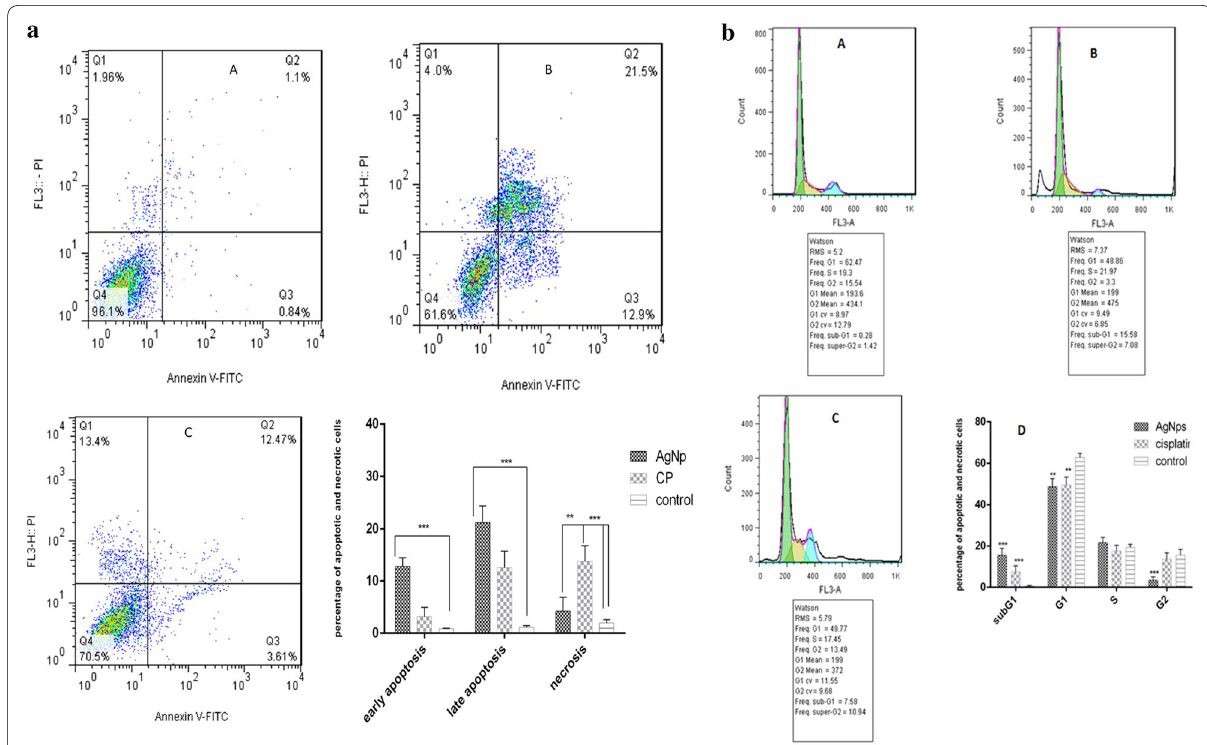
Fig. 7 a Flow cytometric analysis by Annexin V-FITC in the y-axis and PI (FL3) in the x-axis double staining of A549 cell line treated with green-synthesized AgNPs and cisplatin after 24 h of exposure. Dot plots of Annexin V/PI staining are shown in ( a ) Untreated A549 cells, b A549 cells treated with IC 50 concentration of AgNPs. c A549 cells treated with IC 50 concentration of